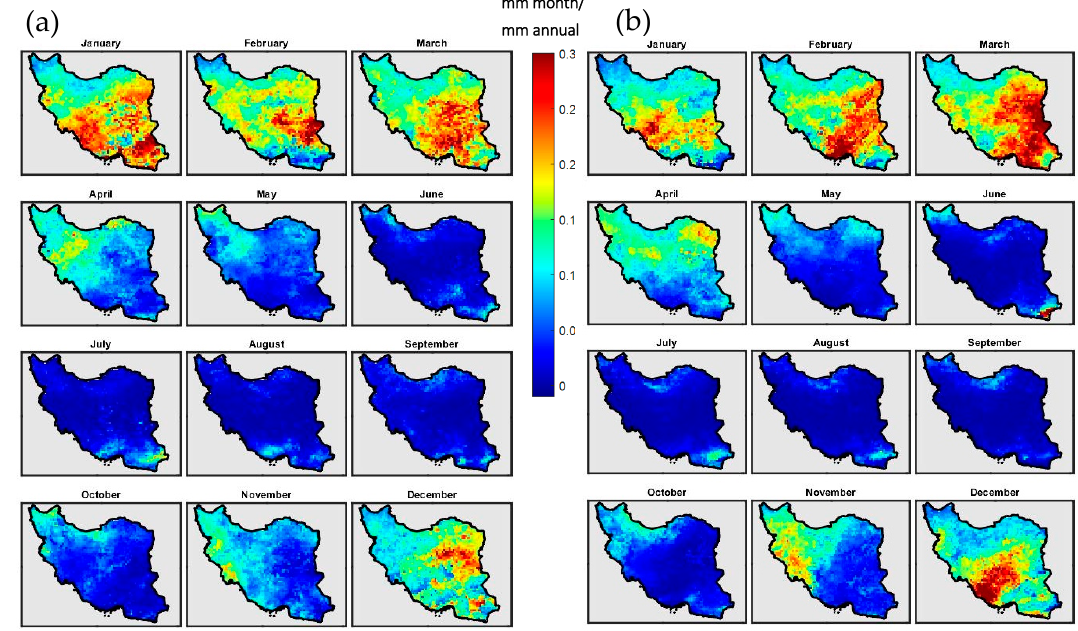
Figure 8. Average percentage of each monthly contribution in annual precipitation in ( a ) dry and ( b ) wet years.